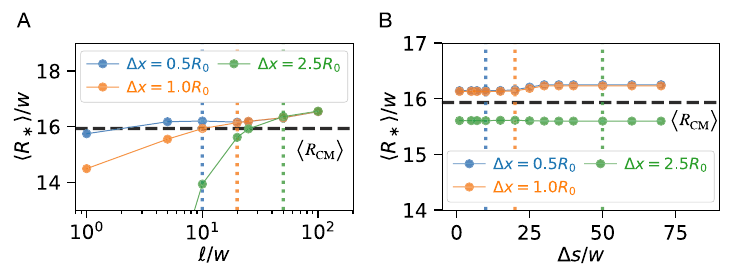
Figure 2. Effect of annular shell thickness ℓ and sector size (cid:31) s in simulations of a passive droplet pair. ( A ) Mean R 0 . The ground R droplet size (filled dots) as a function of ℓ for various (cid:31) x (vertical dotted lines) using (cid:31) s ≈ � ∗ � R CM R truth (black dashed line) is obtained from the continuous model. ( B ) as a function of (cid:31) s (filled (cid:31) (cid:30) � ∗ � R 0 , with R CM dots) for various (cid:31) x using ℓ shown as the black dashed line. ( A , B ) Two droplets with radii ≈ (cid:31) (cid:30) R 0 20 w are placed with their centers 10 R 0 apart in an empty background, φ out ( r , t 0 ) 0 . Continuous = = = 0, 682 w simulations given by Eq. (3) used an azimuthally symmetric cylindrical domain with bounds r , z ∈ [ ] 3 0, 1000 w with a spatial discretization of 0.5 w . Effective simulations used a 3-dimensional cubic domain of size [ ] 0 , � 0 , φ ( 0 ) 0.166 w . Additional parameters are s w 2 / b τ , φ ( 0 ) out w 2 / D out , and 1 , τ and l γ ,in in = = = = = = w 2 √ κ/ b =